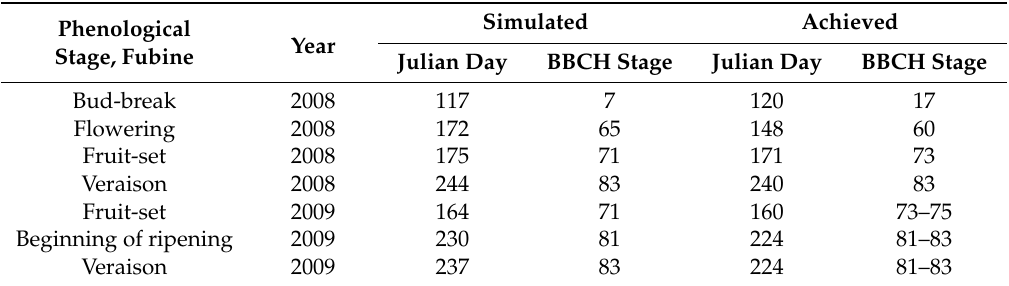
Table 3. Comparison between occurrence of simulated phenological stages (with their associated BBCH stages) and BBCH achieved stage in the Fubine